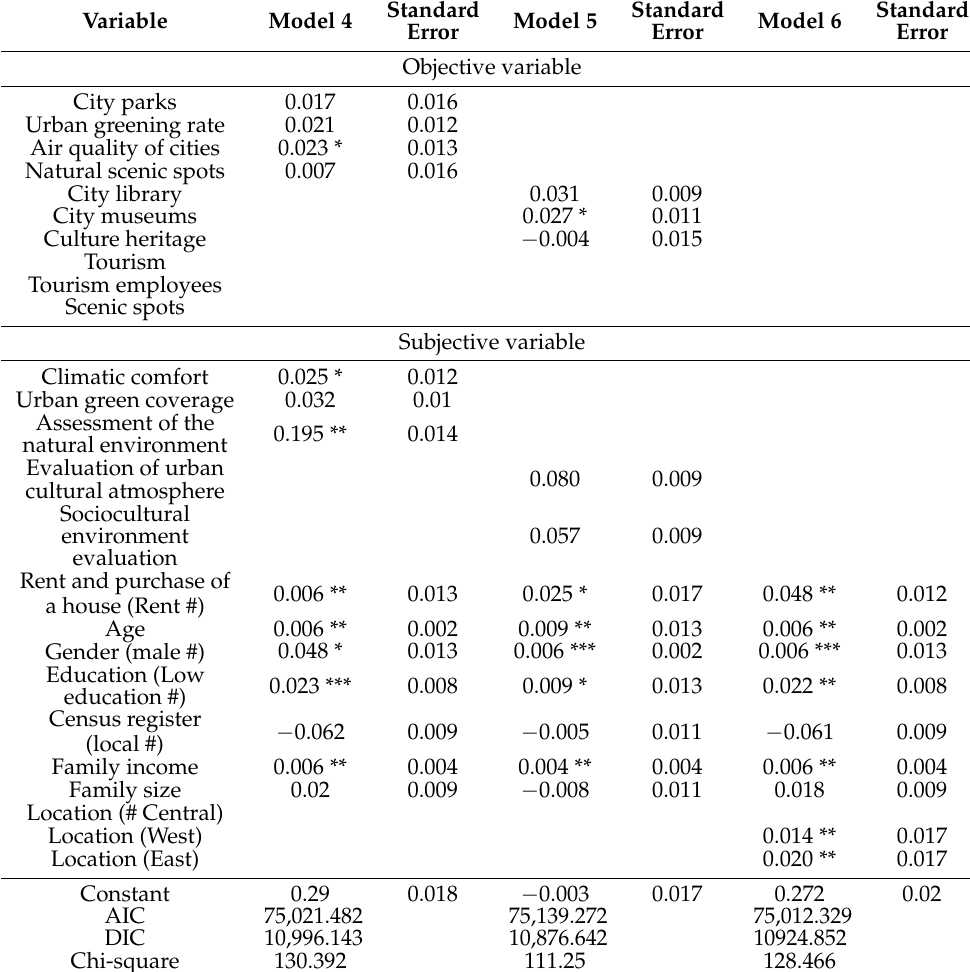
Table 3. Model estimation results with objective variables and subjective